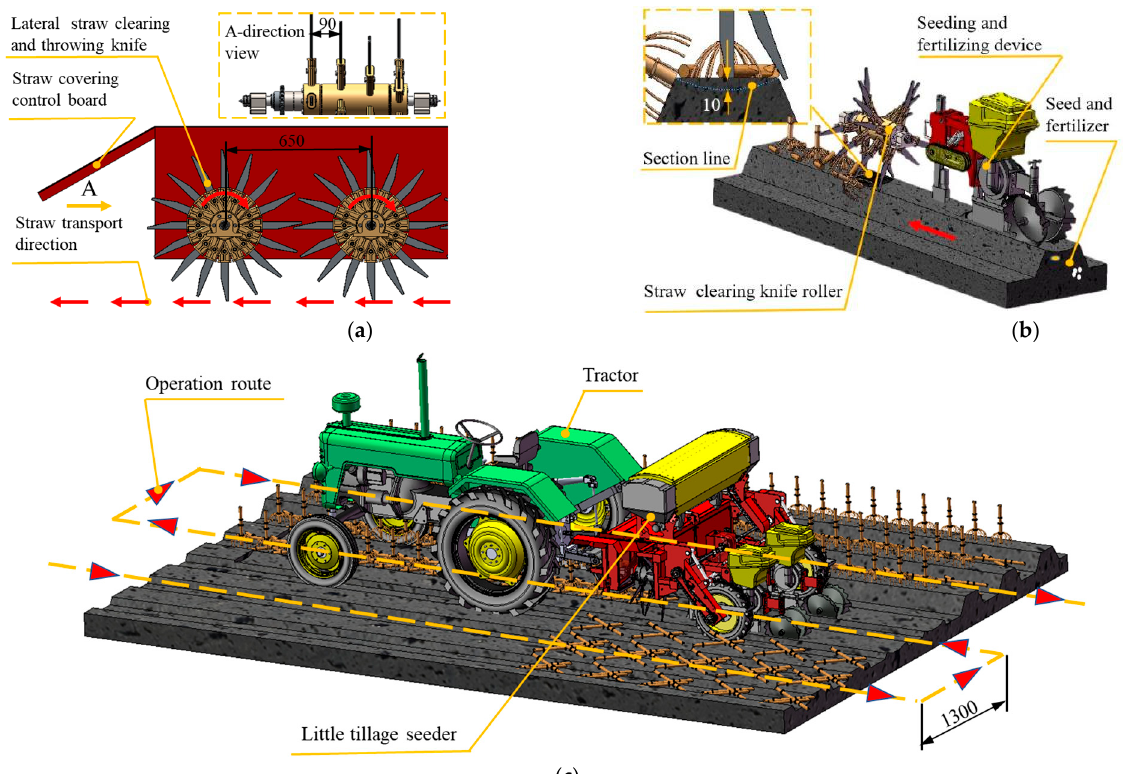
Figure 1. Structure and operation principle of the straw clearing and covering minimum tillage seeder. ( a ) Structure and arrangement of the straw clearing knife roller. ( b ) Configuration relationship and operation principle of the straw clearing knife roller and seeding and fertilizing device. ( c ) Operation principle of the straw clearing and covering minimum tillage